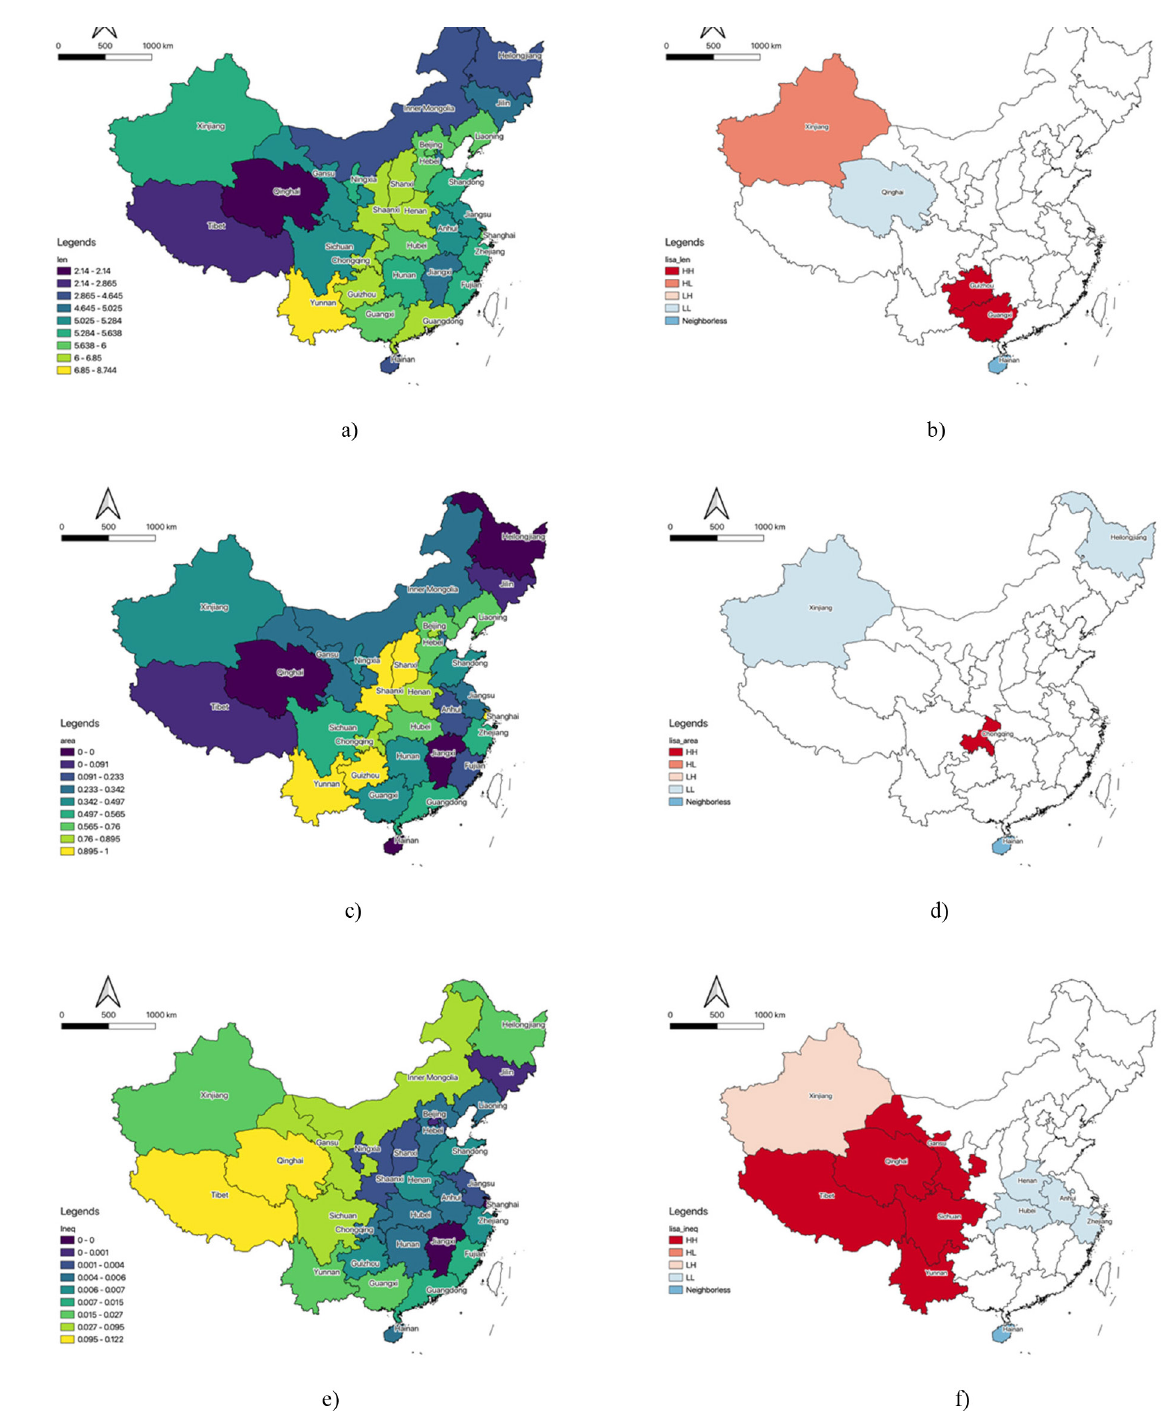
Figure 3. Spatial distribution and association of climate suitability indices: a) spatial distribution of PER; b) local Moran’s I of spatial association of PER; c) spatial distribution of ZONE; d) local Moran’s I of spatial association of ZONE; e) spatial distribution of INEQ; f) local Moran’s I of spatial association of